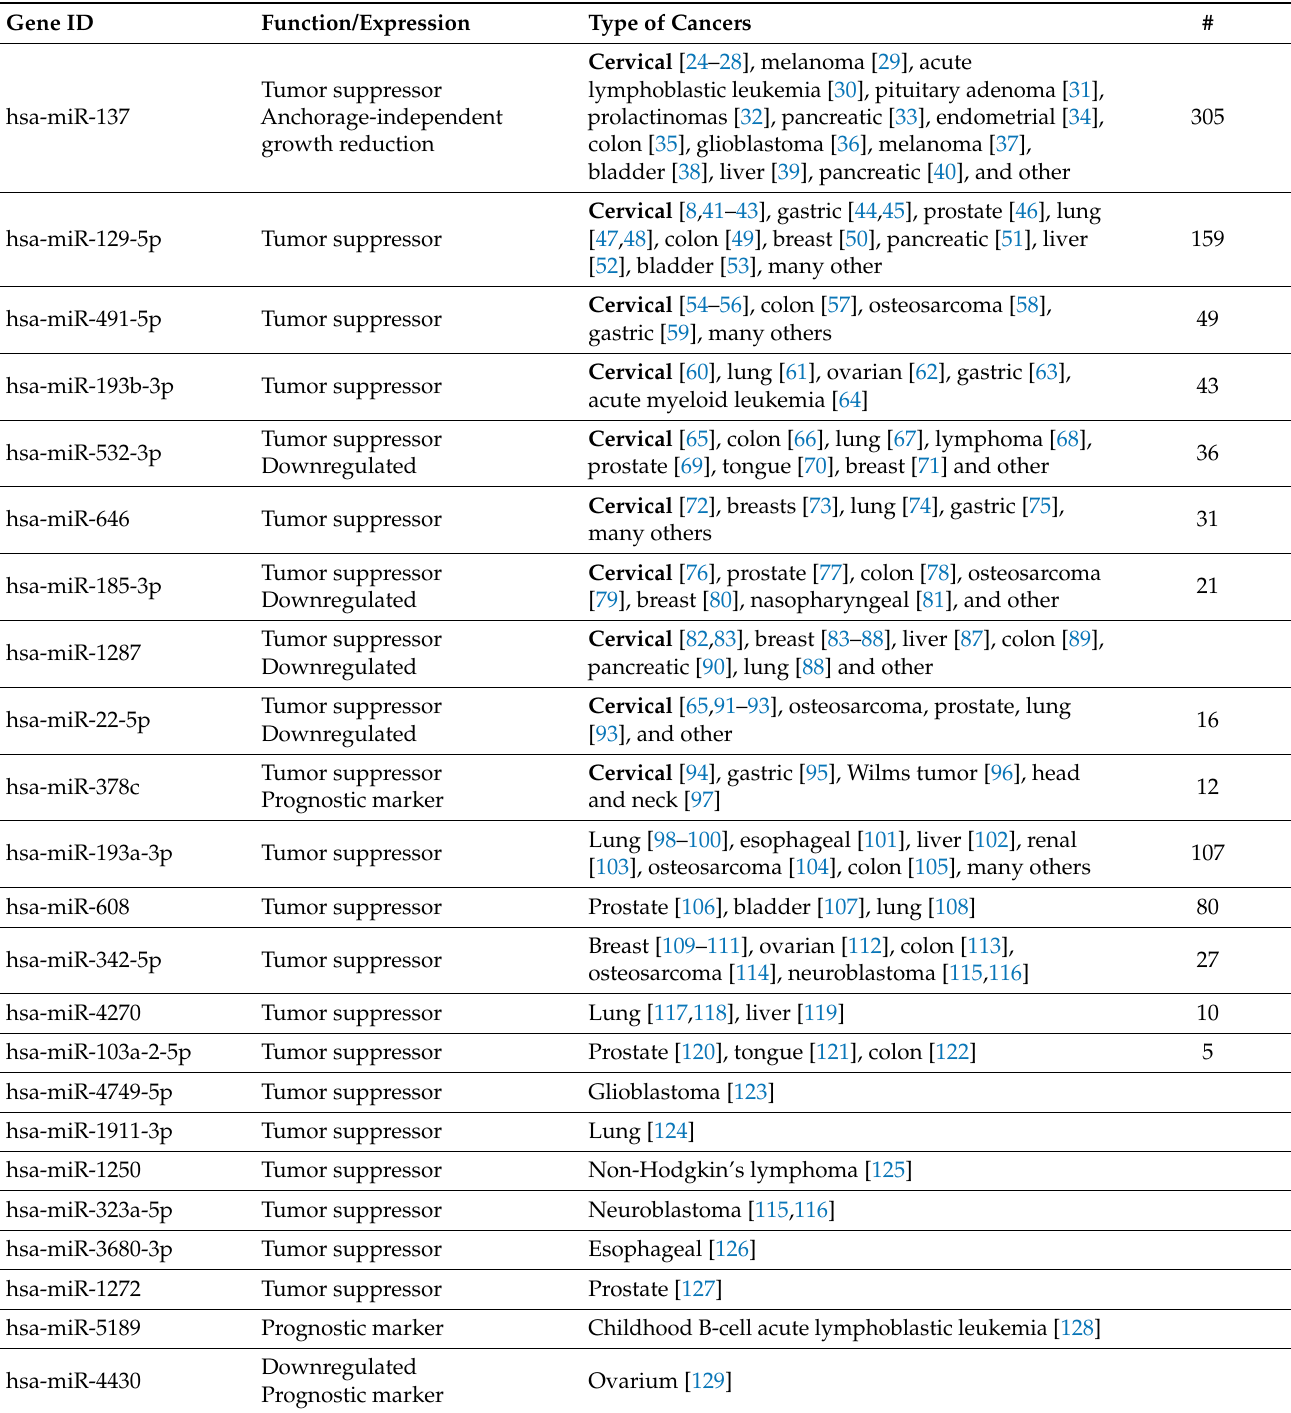
Table 2. Literature search of 40 identified “ULA-norm-Ad” hits in relation to their role in